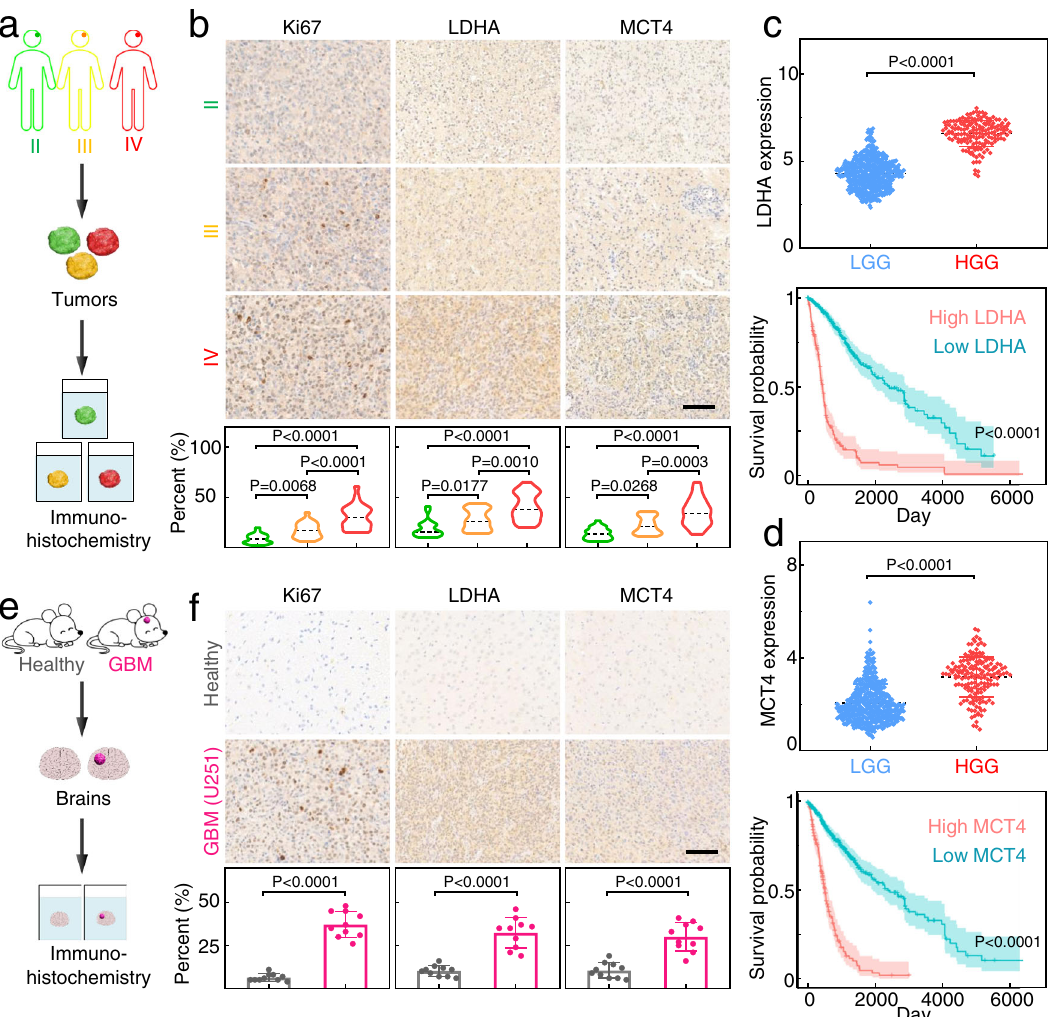
Fig. 2 Pro fi ling of LA metabolism-associated indicators expression in gliomas obtained from patients or mice. a Schematic illustration of LA metabolism-related indicators (LDHA and MCT4) analysis in tumor samples from glioma patients. b IHC images and quantitative analysis of the expression of Ki67, LDHA, and MCT4 in grade II, III, and IV gliomas resected from glioma patients (II: n = 22, III: n = 21, IV: n = 23). Scale bar: 100 μ m. c Assessment of LDHA expression and the corresponding survival probability of glioma patients. Data from The Cancer Genome Atlas (TCGA) database, including 524 low-grade glioma (LGG) and 167 high-grade glioma (HGG) cases. Each dot represents an individual case. The OncoLnc tool was used to explore the relationship between survival probability and LDHA levels. d MCT4 expression and the corresponding survival probability of the same glioma samples in panel ( c ). The OncoLnc tool was used to explore the relationship between survival probability and MCT4 levels. e Schematic illustration of LA metabolism-related indicators analysis for brains from healthy and U251 CDX tumor-bearing mice. f IHC images and quantitative analysis for the expression of Ki67, LDHA, and MCT4 in brain samples from healthy mice and U251 CDX tumor-bearing mice ( n = 1 experiment, n = 10 mice per group). Scale bar: 100 μ m. Data in ( b – d , f ) were presented as the mean ± SD. P values were calculated by using one-way ANOVA ( b ) or two-tailed unpaired Student ’ s t -test ( c , d , f ). Source data are provided in the Source data fi